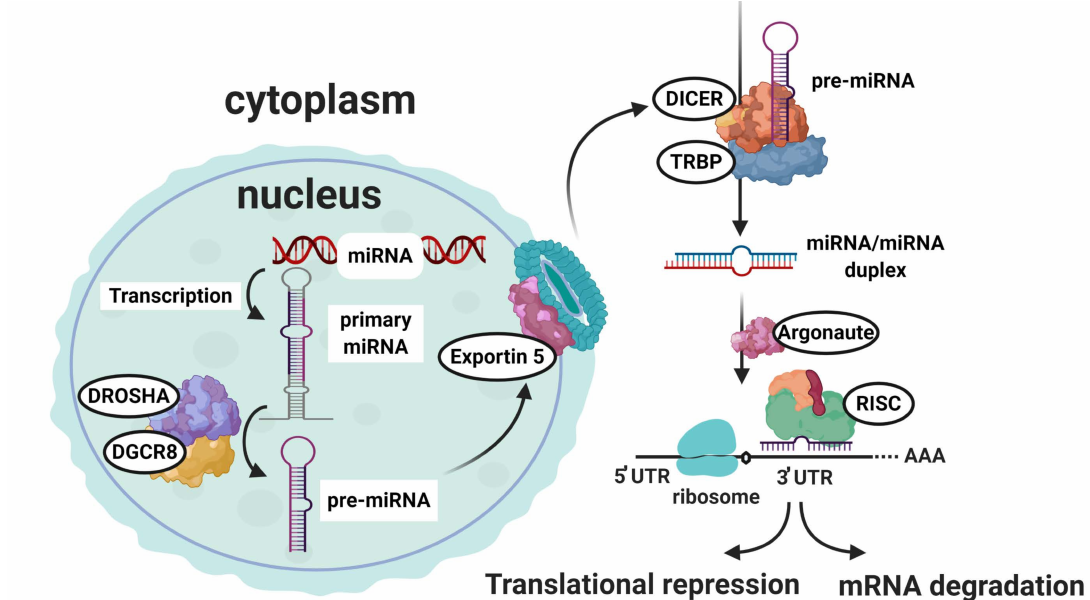
Figure 2. MicroRNA biogenesis and their predominant mode of action. The initial step in the microRNA (miRNA) biogenesis is generation of the primary (pri)-miR transcript. The DROSHA and DiGeorge Syndrome Critical Region 8 (DGCR8) microprocessor complex cleaves the pri-miRNA to form the precursor (pre)-miRNA. The pre-miRNA is then exported to the cytoplasm via Exportin 5. Exportin 5 delivers its cargo to be processed to the mature miRNA duplex by DICER. Finally, the mature miRNA duplex is loaded into the Argonaute (AGO) protein to form the miRNA-induced silencing complex (miRISC). In most cases, miRISC binds to target mRNAs to induce translational inhibition, but can also lead to mRNA degradation via recruitment of